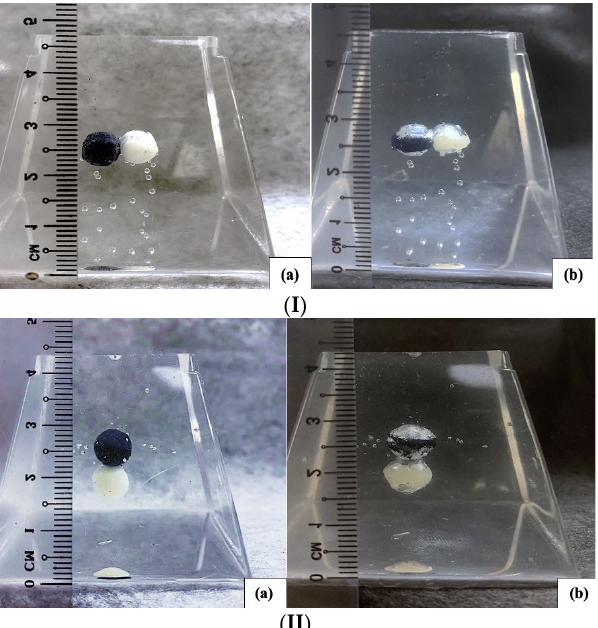
Figure 9. Two inclusions in contact with each other, before ( a ) and after ( b ) programming via high temperature compression in the vertical direction. ( I ) Two spherical inclusions packed horizontally; ( II ) two spherical inclusions packed vertically. The black inclusion was filled with carbon black. It appears that programming-induced gaps can provide a sound explanation for side/surface and programming mode-dependent hardness in programmed shape memory hybrids.